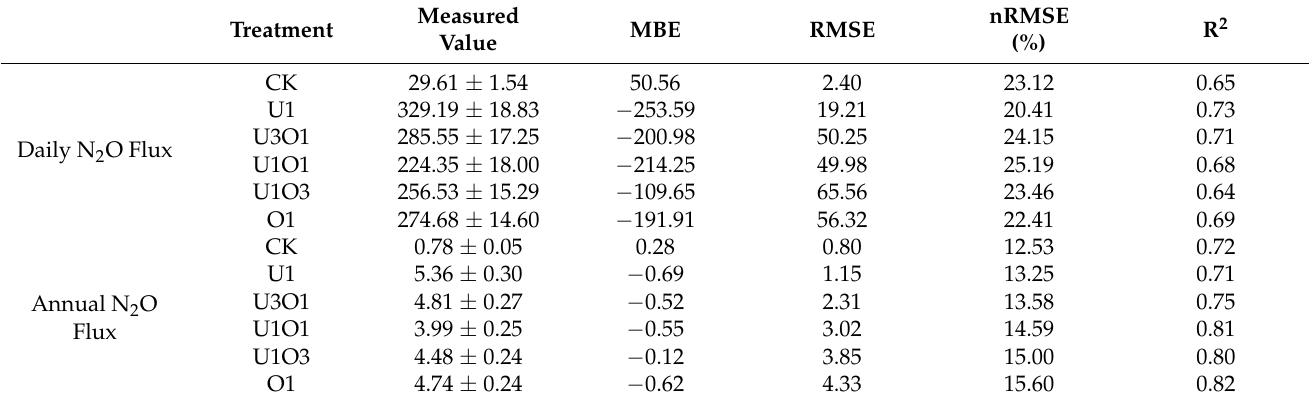
Table 6. Statistical evaluation between the modeled and measured daily N 2 O fluxes (g N ha − 1 d − 1 ) and annual N 2 O fluxes (kg N ha − 1 ).